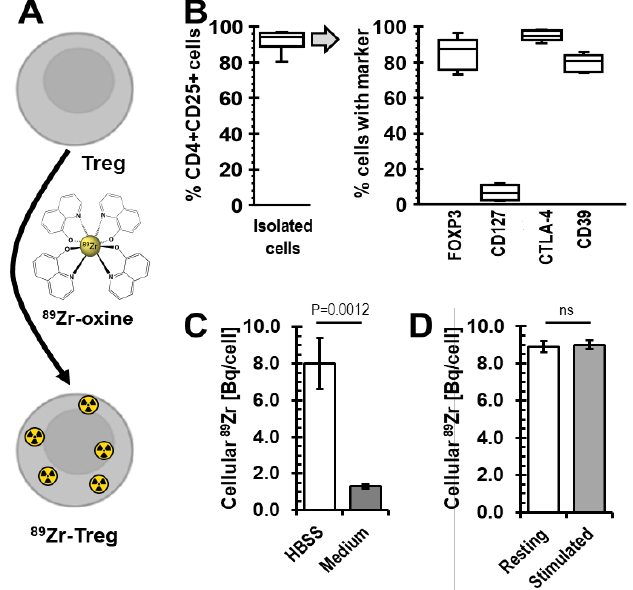
Figure 1. Human expanded Treg isolation and radiolabelling with 89 Zr. ( A ) Scheme depicting the radiolabelling agent. ( B ) Isolated human expanded Tregs were analyzed by flow cytometry; the right panel shows expression of the CD4 + CD25 high population from the left panel; n = 9 Treg isolations from different donors; box–whisker plot including the median line. For gating see Supplementary Figure S1. ( C ) Higher cellular 89 Zr uptake was obtained when radiolabelling of Tregs with 89 Zr-oxine was performed in saline compared to the optimal Treg growth medium (serum-free); n = 3 different Treg batches, error bars are SD. ( D ) We found no difference in radiolabelling efficiency when comparing resting and CD3/CD28-bead-stimulated Tregs; n = 3 different Treg batches, error bars are